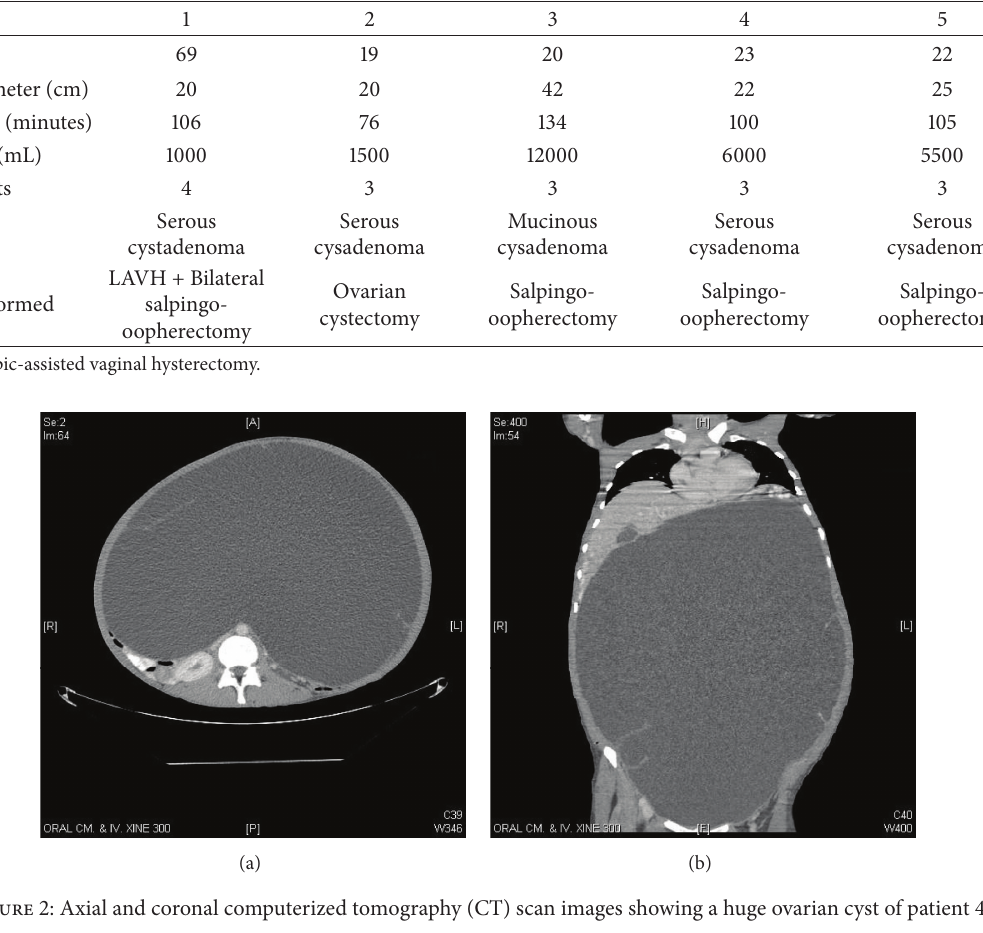
more than twenty centimeter; only few case series and case reports are